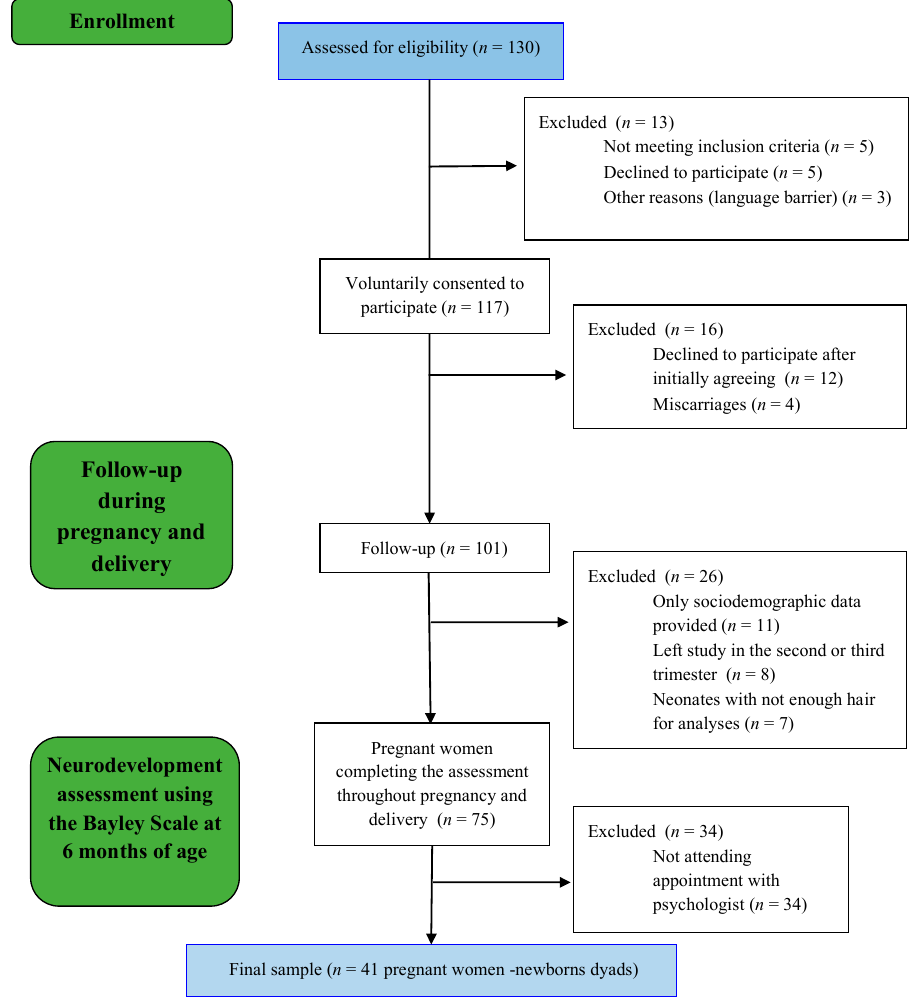
Figure 1. Participants’ follow-up flow diagram.